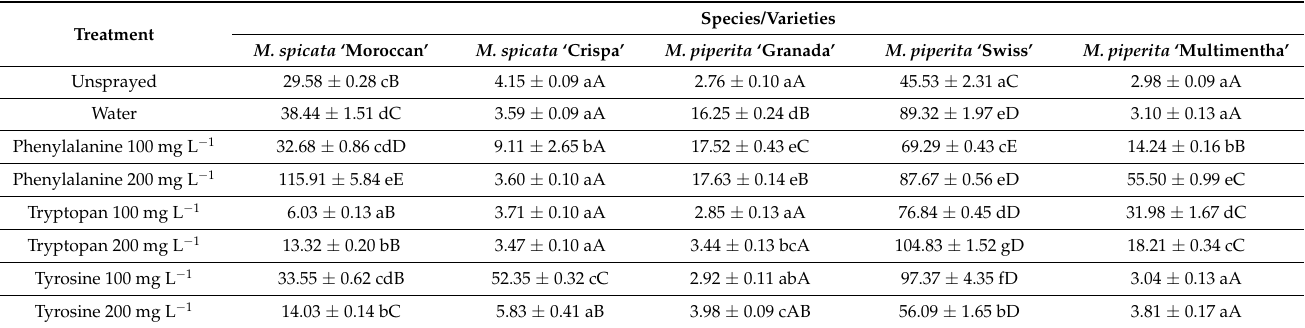
Table 5. Quercetin content in mint influenced by foliar application of amino acids, mg 100 g − 1 DM in 2017–2018.